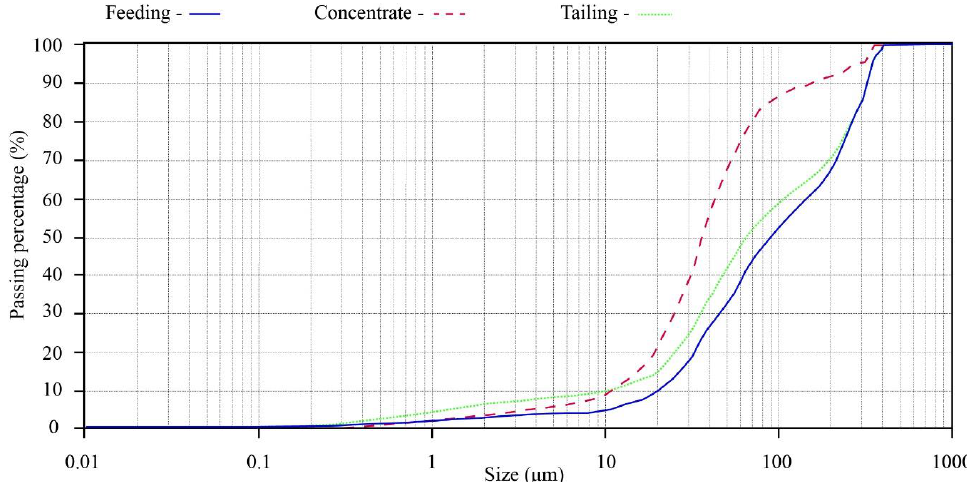
Figure 4. Particle size distributions of the feed (F-1 to F-5), concentrate (CC-1 to CC-5), and tailing (T1-T5) samples resulted from the physical separation process employed in Figure 3.